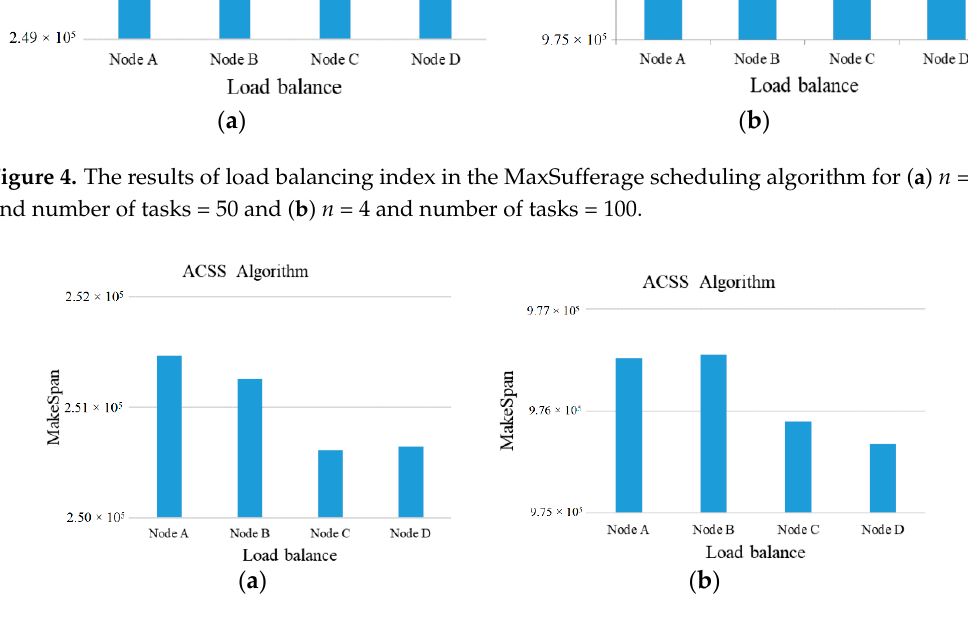
Figure 5. The results of load balancing index in the Advanced Cluster Sufferage Scheduling (ACSS)